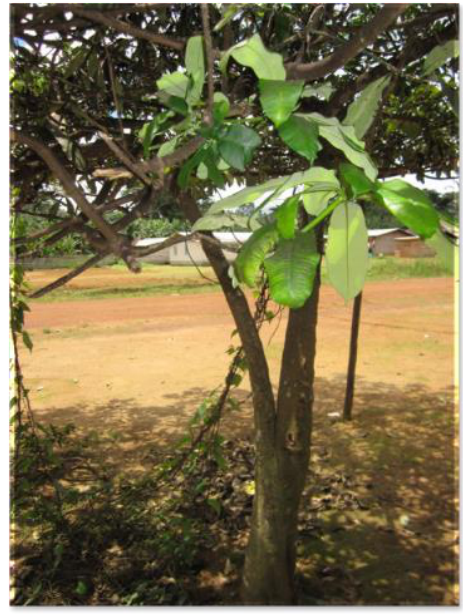
Figure 1. Ekuk tree in Akonibe District.